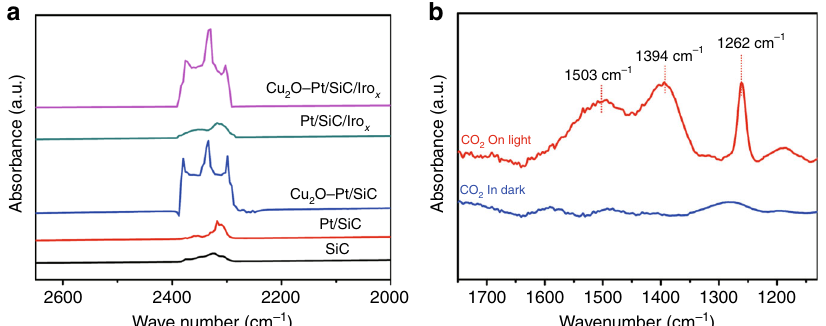
Fig. 7 Adsorption of CO 2 on photocatalysts. a In situ FT-IR spectra of CO 2 adsorbed on different photocatalysts. b In situ FT-IR spectra of CO 2 adsorbed on Cu 2 O – Pt/SiC/IrO x before and after visible light irradiation. All the spectra are the difference spectra between after and before CO 2 adsorption.